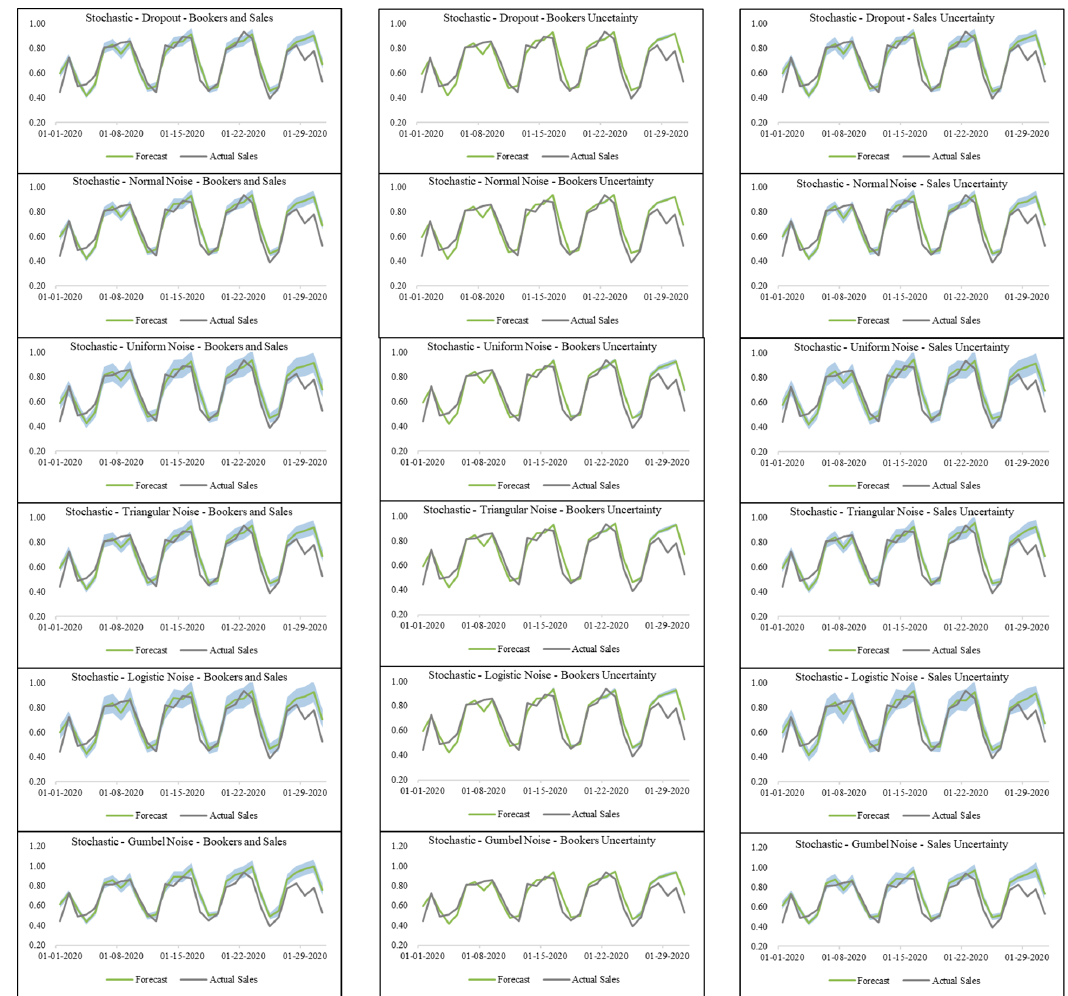
Figure A1. Actual vs. predicted sales forecast of (1) stochastic dropout models and (2) noise embedded in predicted pales and active booker count input variables. The y-axis represents the normalized sales, whereas the x-axis represents the dates of January 2020. The shaded area represents the range of stochastic variance (uncertainty) in the model predictions.